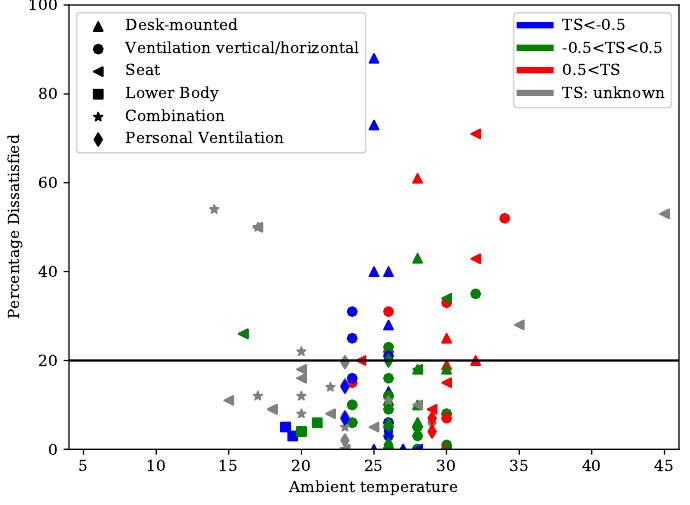
Figure 4. Percentage of dissatisfied individuals with respect to indoor temperature; each depicted point corresponds to a single study extracted from the